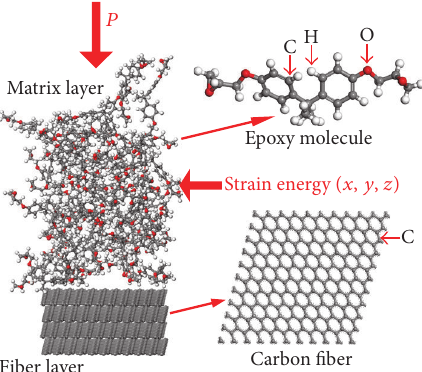
Figure 9: The final microsystem and its boundary